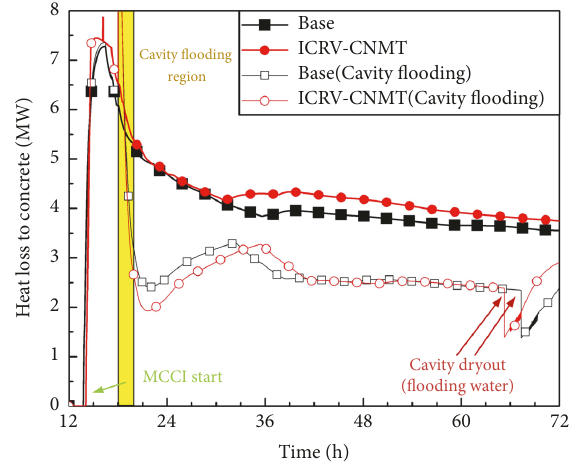
Figure 19: The corium heat loss to concrete in the cases with/ without cavity